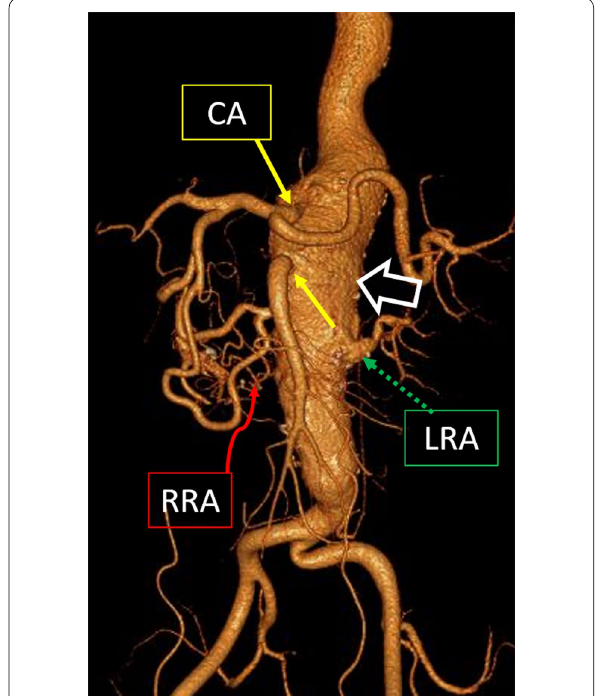
Fig. 3 Volume rendered CT angiogram in frontal projection showing aneurysmal dilation of abdominal aorta (white open arrow) and mild stenoses at ostia of celiac artery (CA) and superior mesenteric arteries (yellow arrows). This patient had atrophy of right kidney secondary to right renal artery (RRA) occlusion (red curved arrow) with single functional kidney on left side supplied by left renal artery (LRA) green dotted arrow. Tortous iliac arteries were noted to have normal